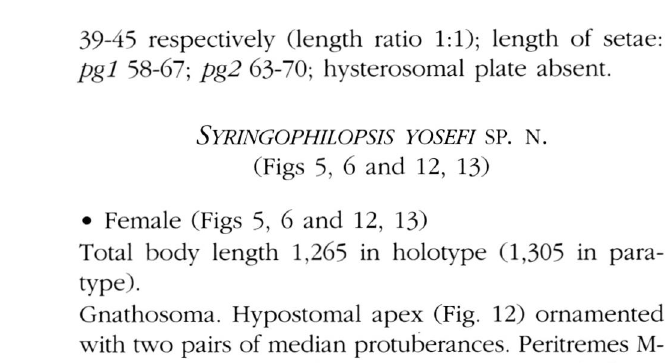
Figs 5, 6. - Syringophilopsis yosefii sp. n. Female. 5- Dorsal view. 6. Ventral